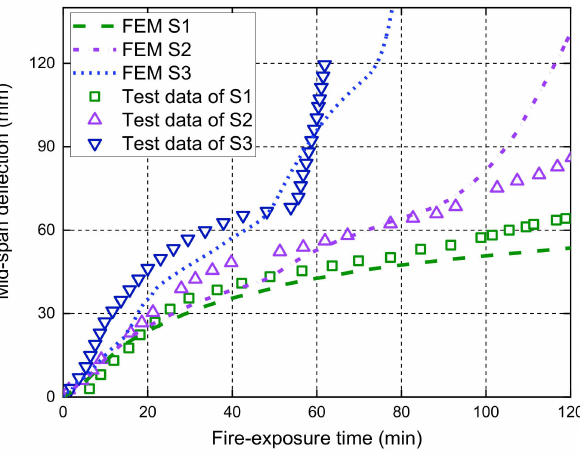
Figure 10. Measured deflection responses versus FE predictions of slabs S1, S2, and